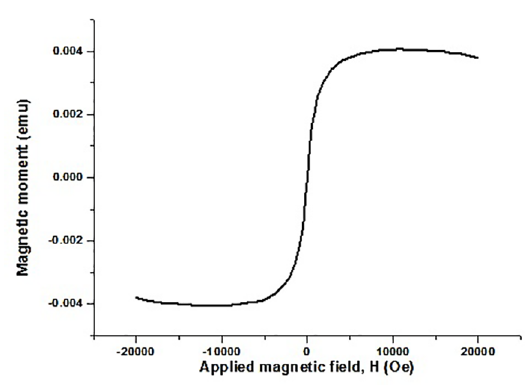
Figure 5. Magnetometric analysis of the natural pyrite.